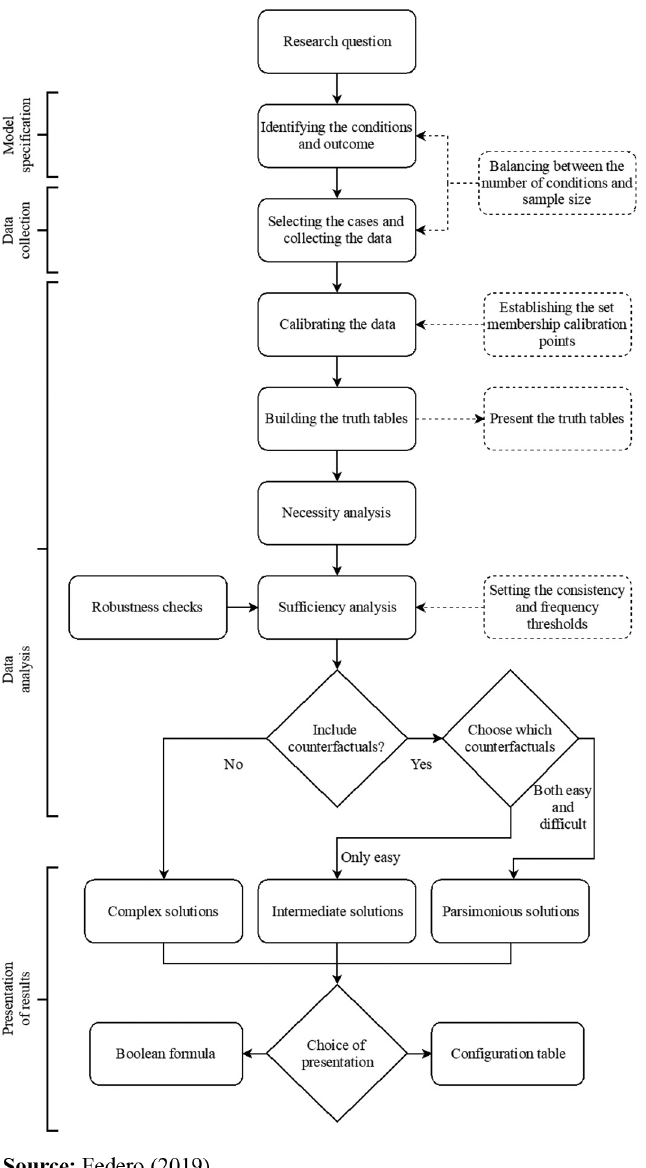
Figure 1. Steps in